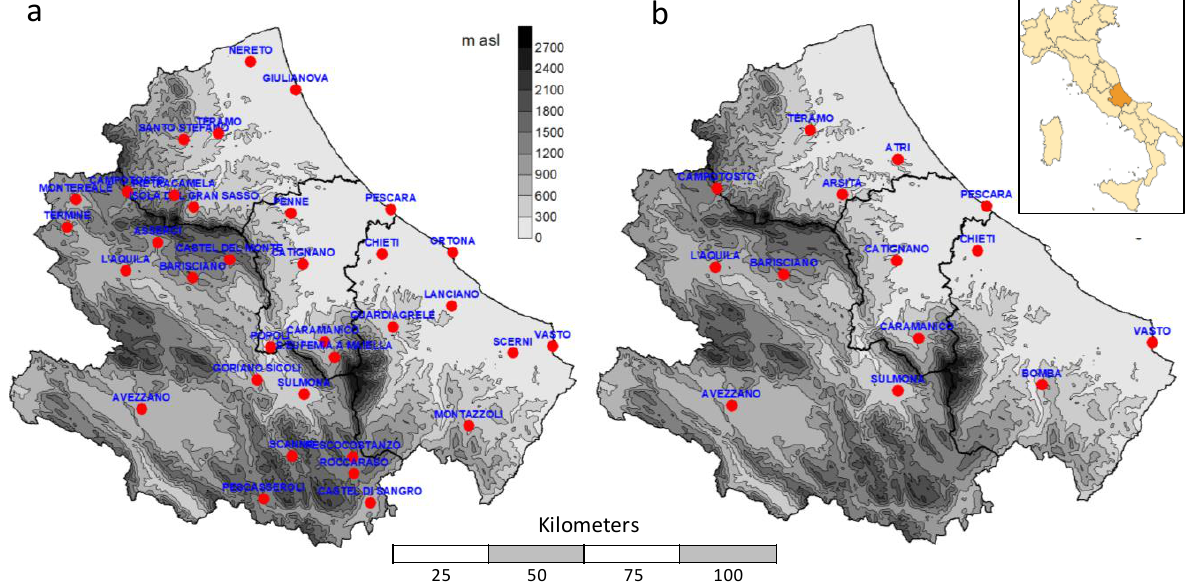
Figure 1. Maps showing orography of Abruzzo region and stations considered: ( a ) stations of point and grid daily rainfall datasets; ( b ) stations of 30-min rainfall dataset.